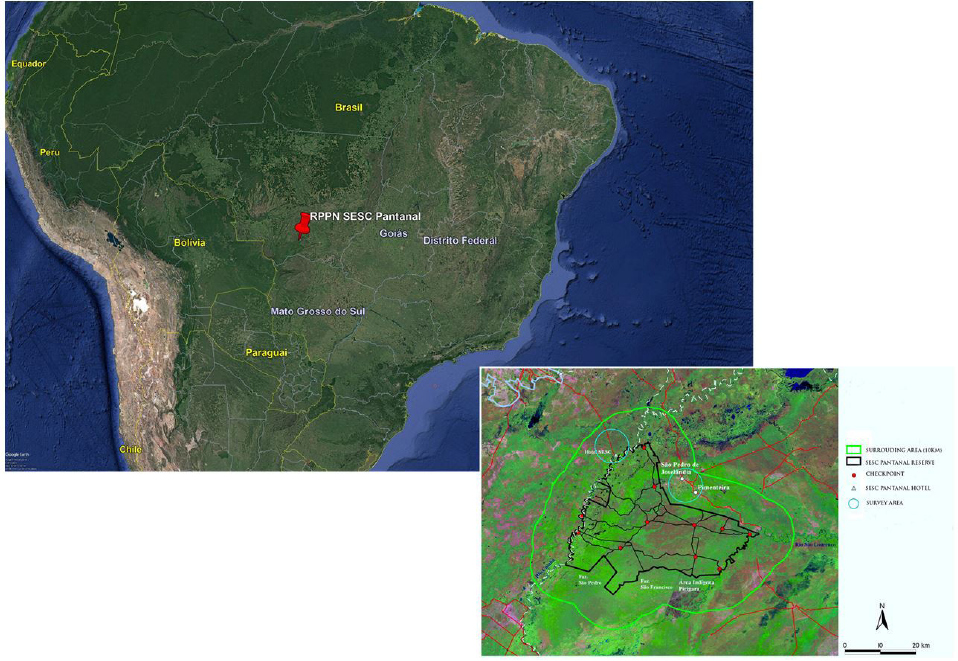
Figure 1. Geographical delimitation of the SESC Pantanal reserve (RPPN SESC Pantanal, 16 ° 40’51 “S; 56 ° 17’45” W). Source: Fiocruz